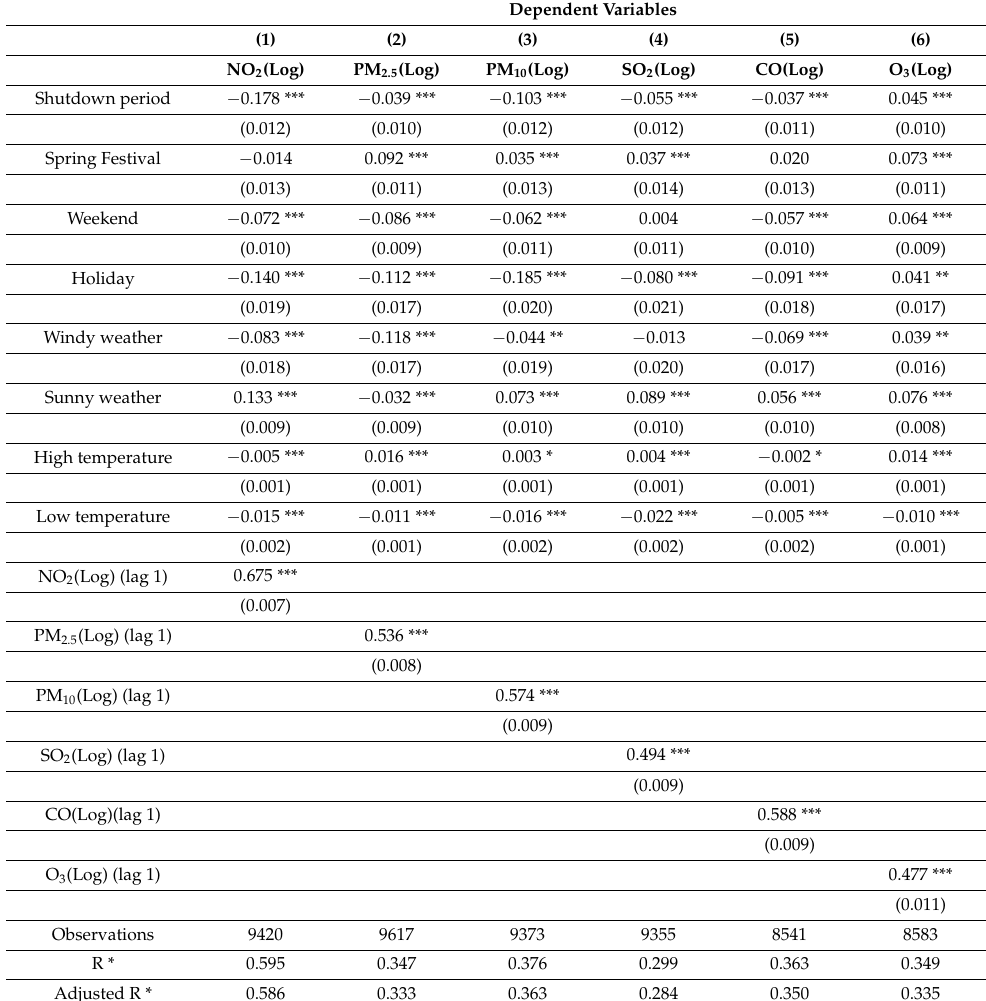
Table 2. Fixed Effects